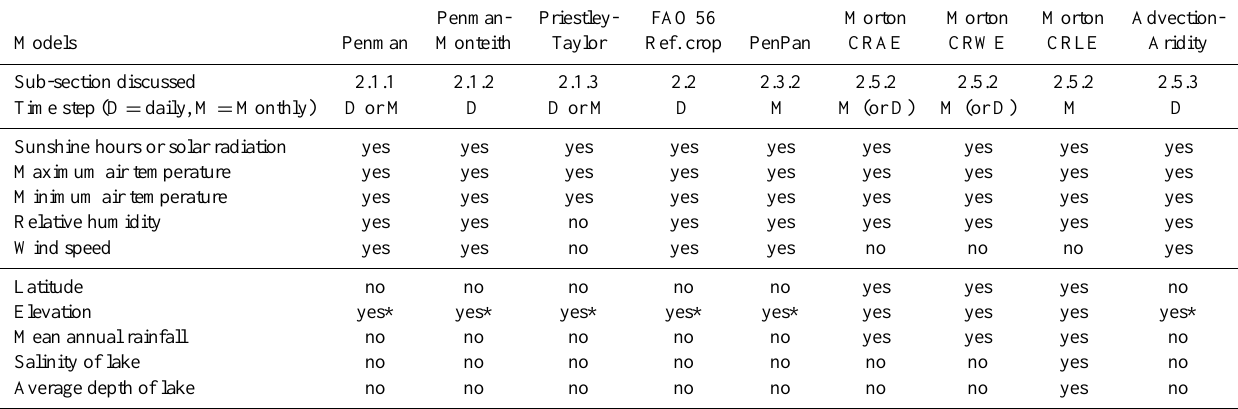
Table 1. Data required to compute evaporation using key models described in the paper. Penman- Priestley- FAO 56 Morton Morton Morton Advection- Penman Monteith Taylor Ref. crop PenPan CRAE CRWE CRLE Aridity Sub-section